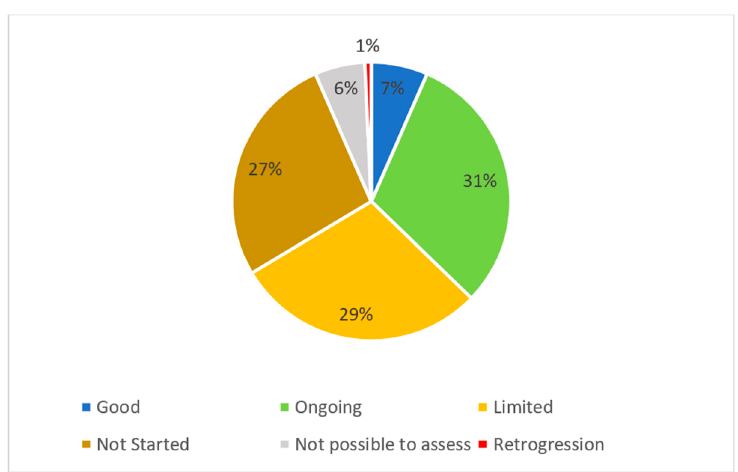
Figure 7. Progress on the implementation of recommendations for seven countries reviewed by the SR.